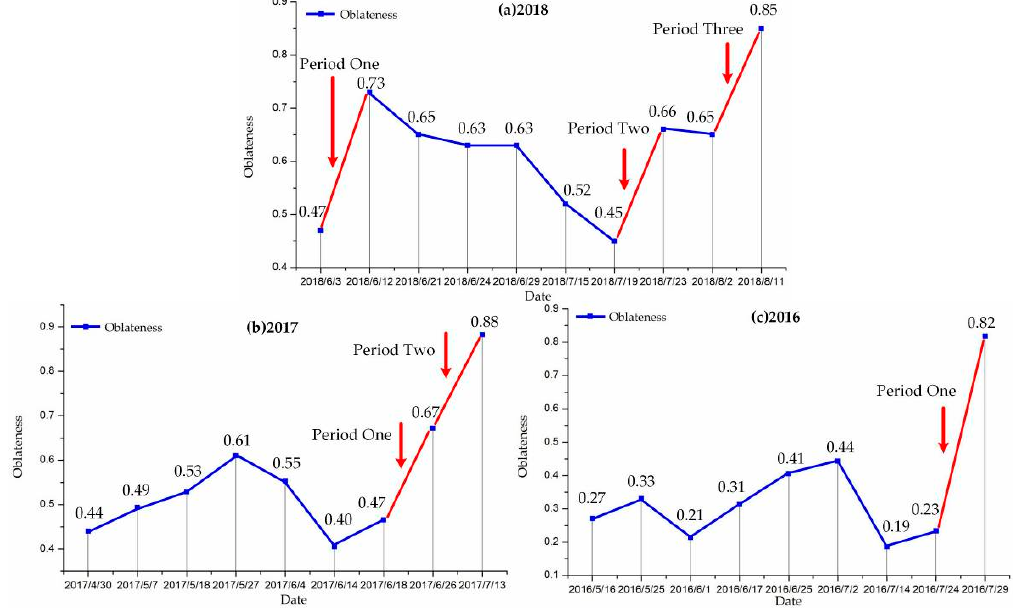
Figure 11. ( a ) Line chart of changes in oblateness in 2018. ( b ) Line chart of changes in oblateness in 2017. ( c ) Line chart of changes in oblateness in 2016. The horizontal coordinate is the date, and the vertical coordinate is the oblateness. The specific value of each date is marked above the broken line. The red segments in the figure indicate the periods when oblateness increased